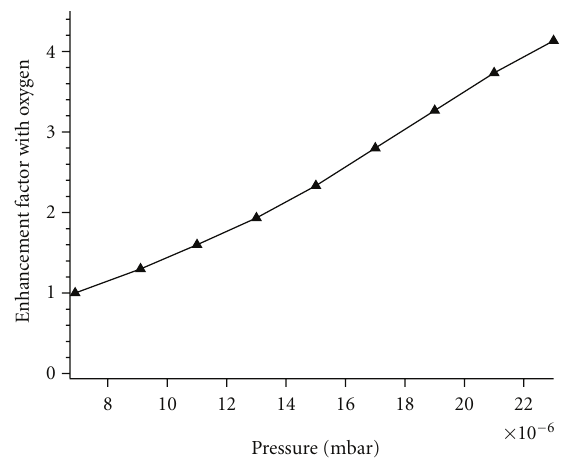
Figure 8: E ff ect of oxygen flow rate on SIMS signal for a cobalt alloy; the graph shows the Co + secondary ion signal as oxygen was bled into the chamber through a needle valve. The plot has been normalised to the signal when the needle valve was closed (i.e., no oxygen flow, chamber pressure 6.9 × 10 − 6 mbar). 5keV, 1270 pA Ga + primary beam, 10 × 10 µ m scan area. It can be seen from the gradient that there is likely a significant oxygen enhancement e ff ect for cobalt secondary ions even at the lowest pressure (with no oxygen flow).